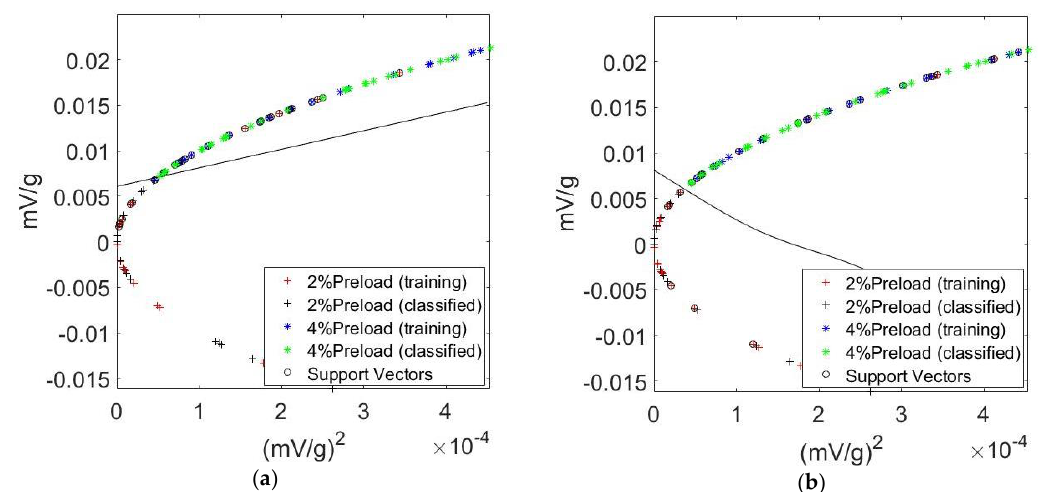
Figure 8. Training and classified results for the ( a ) linear SVM kernel function, and ( b ) nonlinear radius-based function (RBF) SVM kernel function of the vibration signals for the 2% and 4% ball-nut preloads with a pretension of 10 μ.